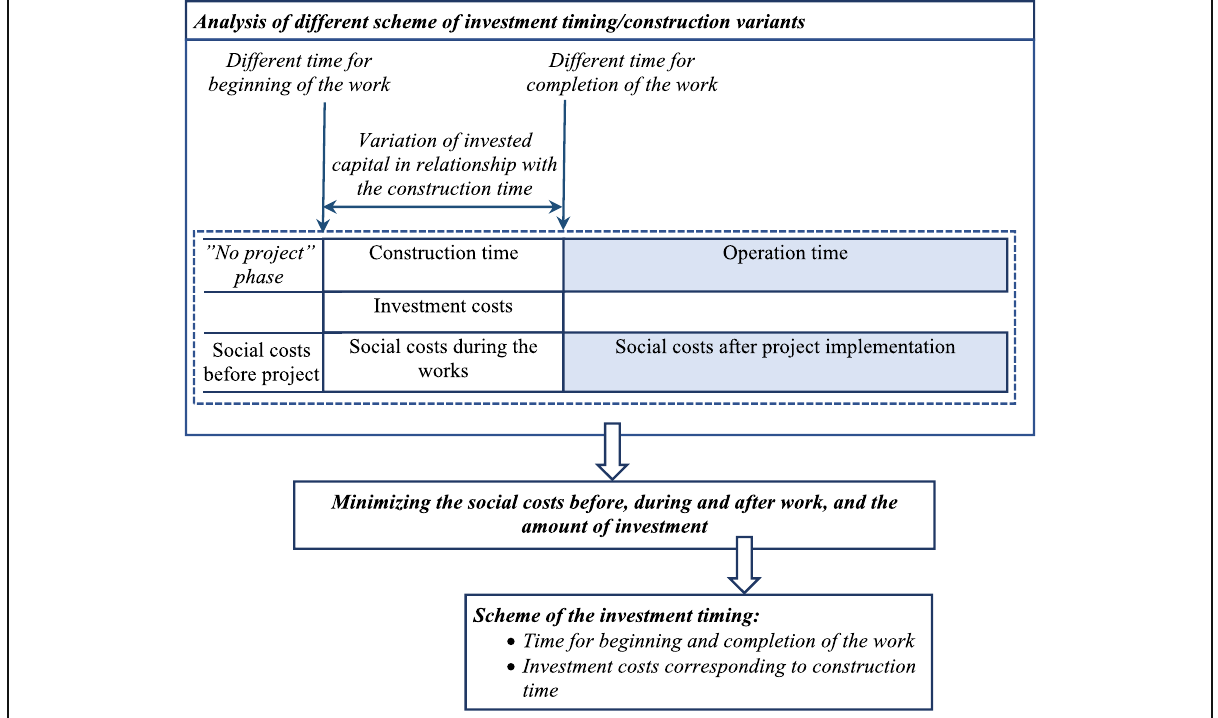
Fig. 8 The structure of the model for selection of the most appropriate investment